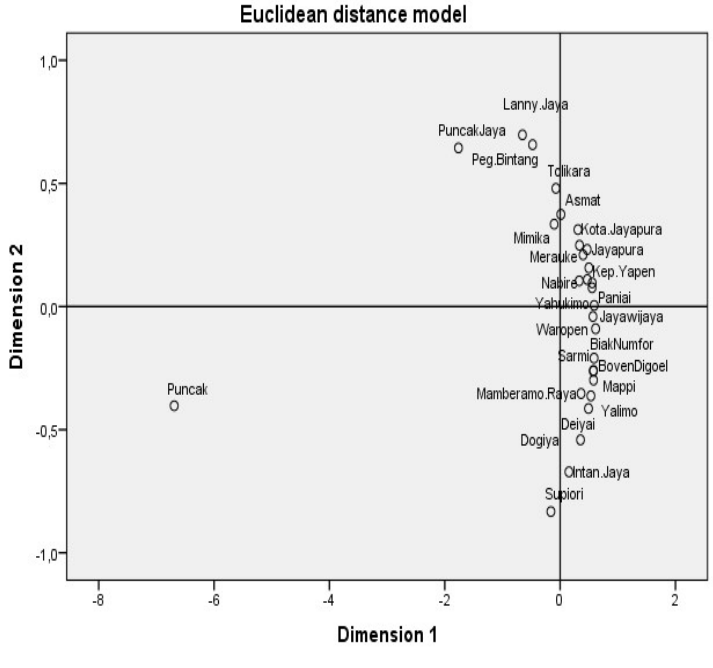
Fig. 3. Multidimensional Scaling of Expenditure